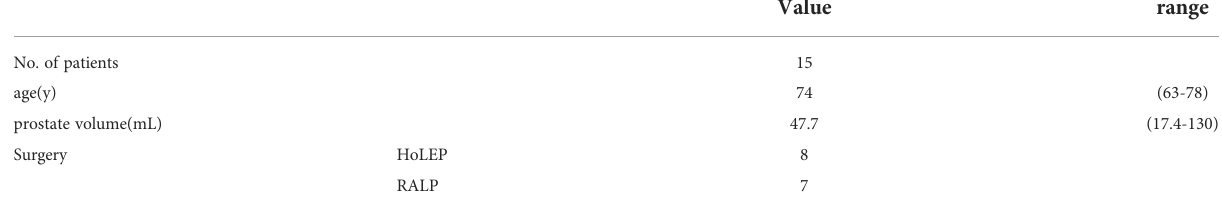
TABLE 1 Background characteristics of patients from whom prostate tissue and catheterized urine samples were taken.